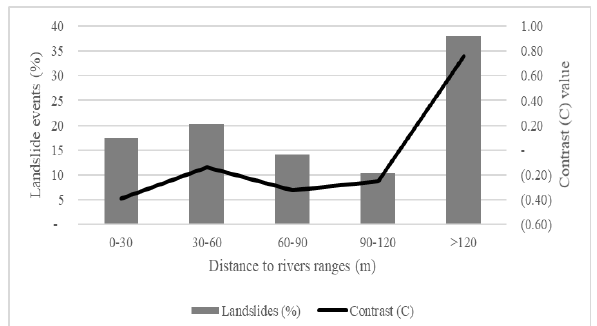
Figure 8 Landslide distribution (%) (left vertical axis) and contrast value (right axis) in distance to rivers